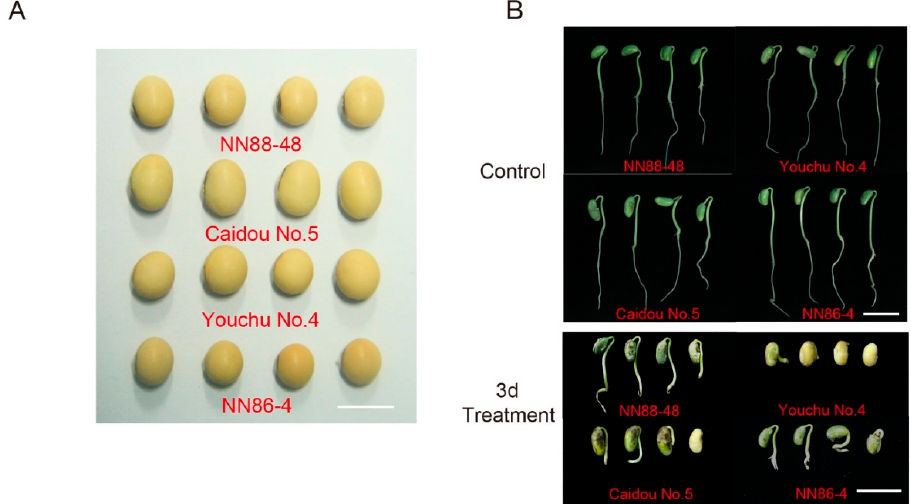
Figure 1. Germination performance of four core lines NN88-48, Caidou No.5, NN86-4 and Youchu No.4. ( A ) Grain shape of four core lines. ( B ) The germination and growth of seedlings among selected four lines under control and three days treatment. Scale bars are 1.0 cm in ( A ) and 3.0 cm in ( B ).